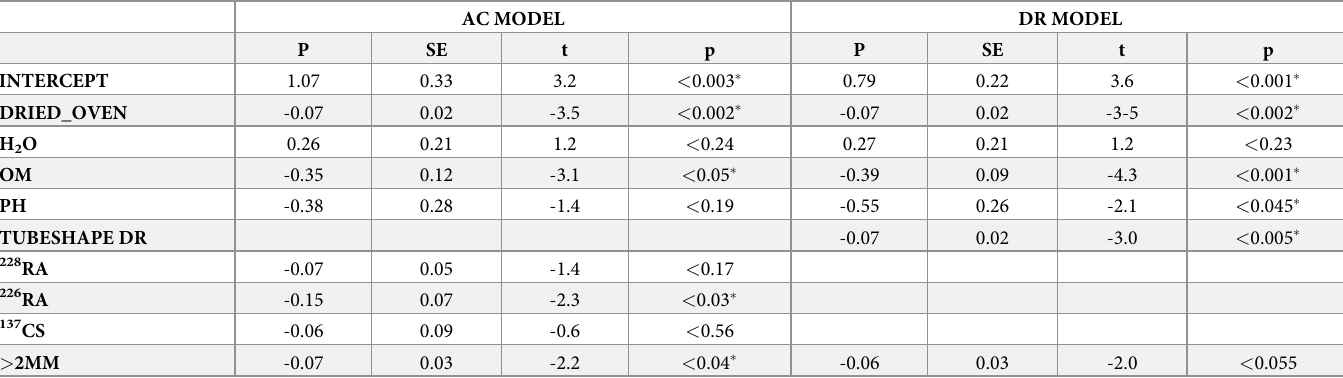
Table 4. Full versions of the two best statistical models.